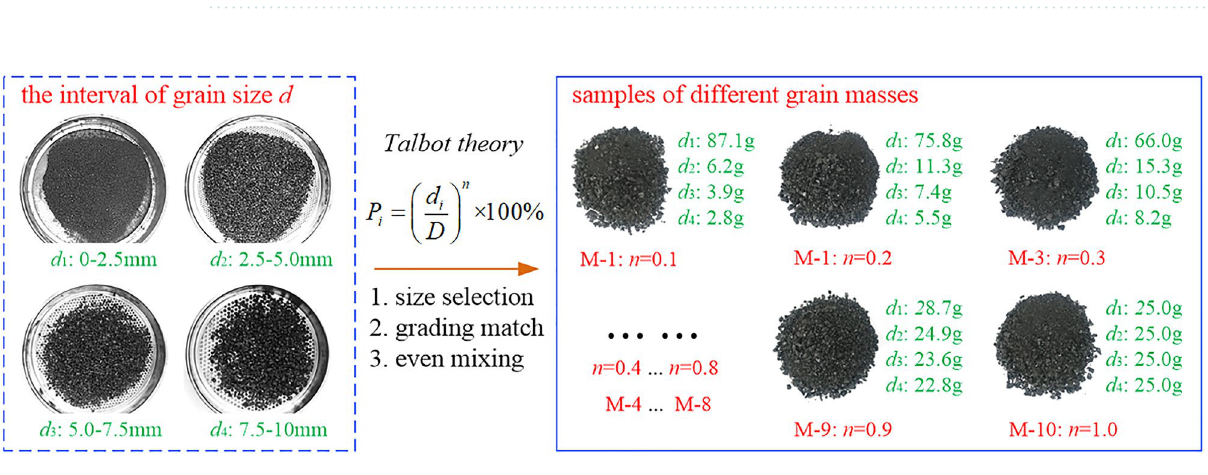
Figure 2. Sample preparation